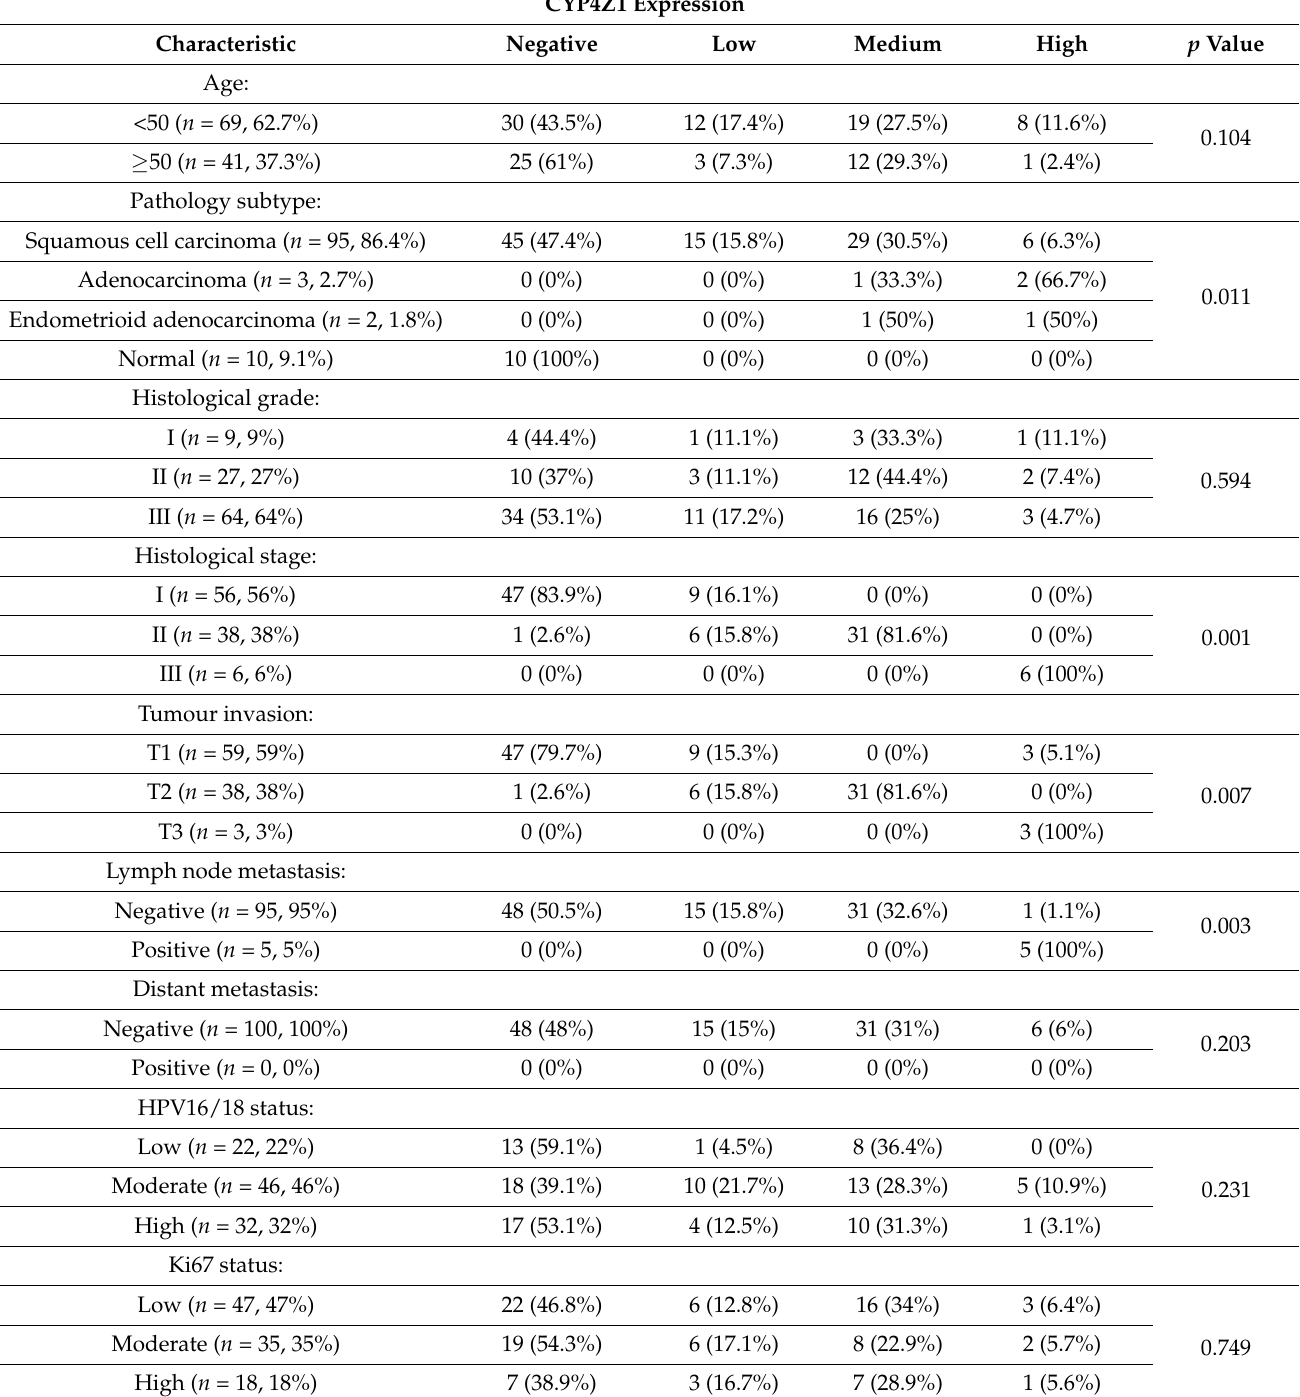
Table 1. Baseline demographic and clinicopathologic features of cervical cancers. CYP4Z1